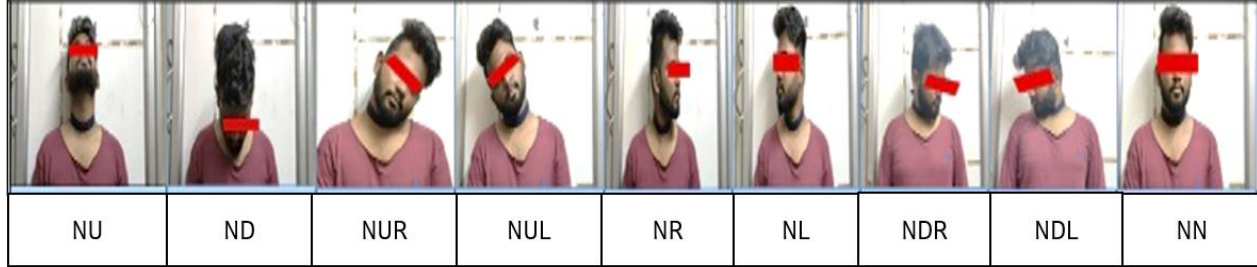
Figure 4. Neck Postures (Nine Positions)—Subject. 1. Neck at Extreme Up ( NU ), 2. Neck at Extreme Down ( ND ), 3. Neck at Extreme Right ( NR ), 4. Neck at Extreme Left ( NL ), 5. Neck at Right Up ( NRU ), 6. Neck at Right Down ( NRD ), 7. Neck at Left Up ( NLU ), 8. Neck at Left Down ( NLD ), and 9. Neck in the Middle ( NM ).